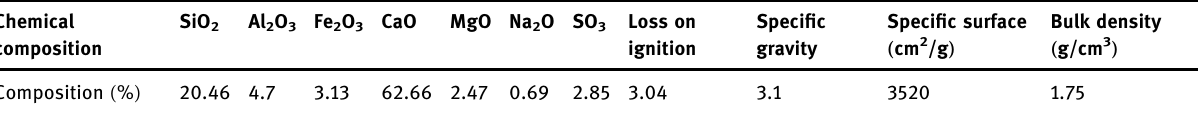
Table 2: Properties of reference cement